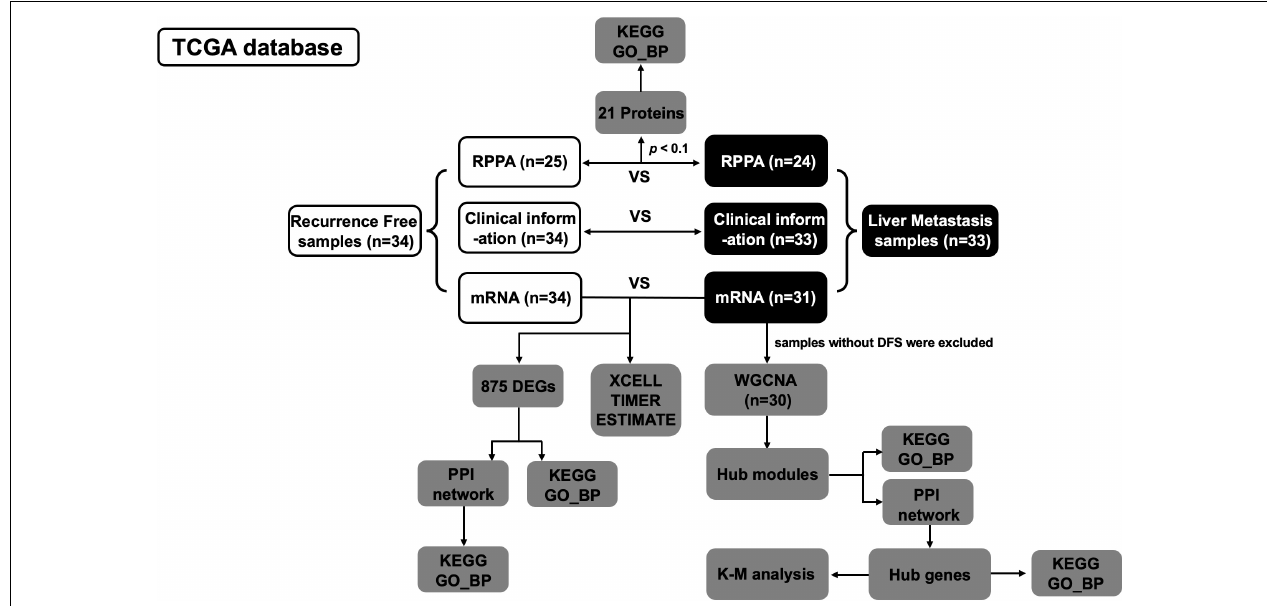
FIGURE 1 | Flowchart of data acquisition, processing, and analysis.